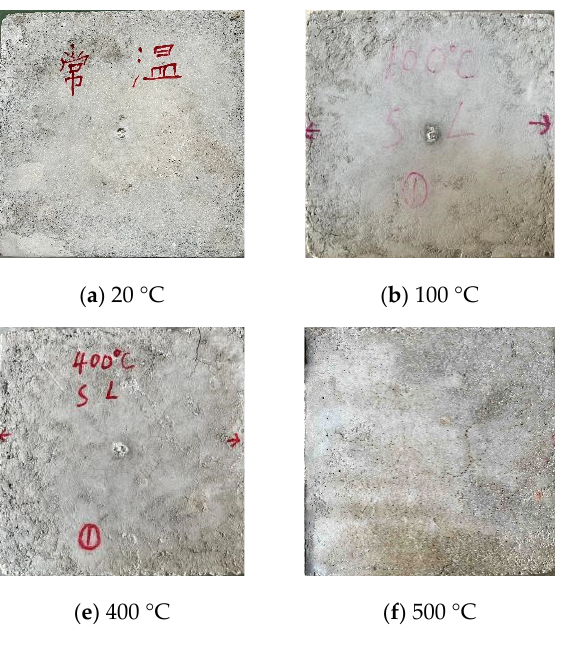
Figure 4. The surface of the SCC specimens cooled in air.